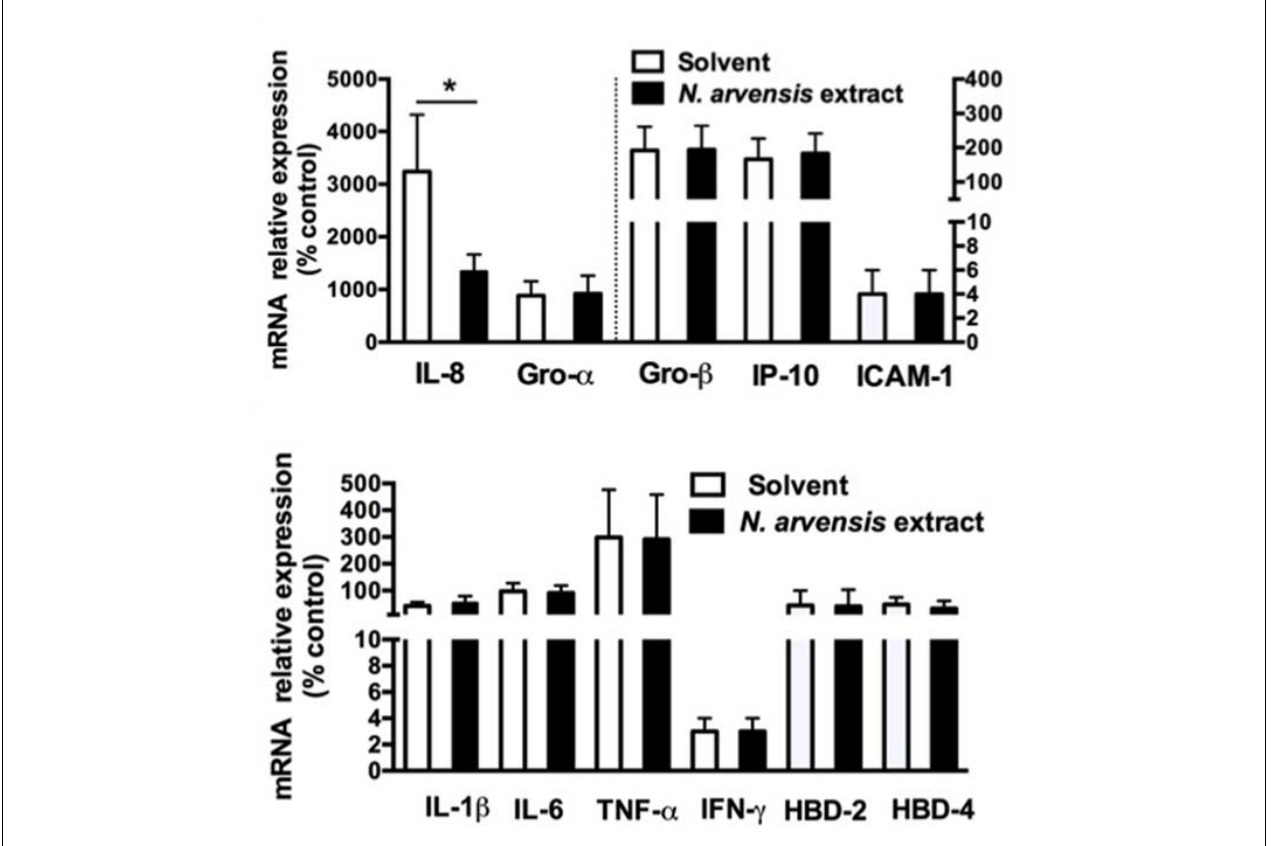
FIGURE 3 | Pseudomonas aeruginosa modulated mRNA expression in IB3-1 cells: effect of N. arvensis extract. IB3-1 cells were treated with the chloroform extract (10 µ g/ml) or solvent alone 16 h before infection with PAO1 (100 CFU/cell) for further 4 h. mRNA expression was measured by real-time qPCR and obtained by comparing the ratio of target to housekeeping gene GAPDH between non-infected and infected